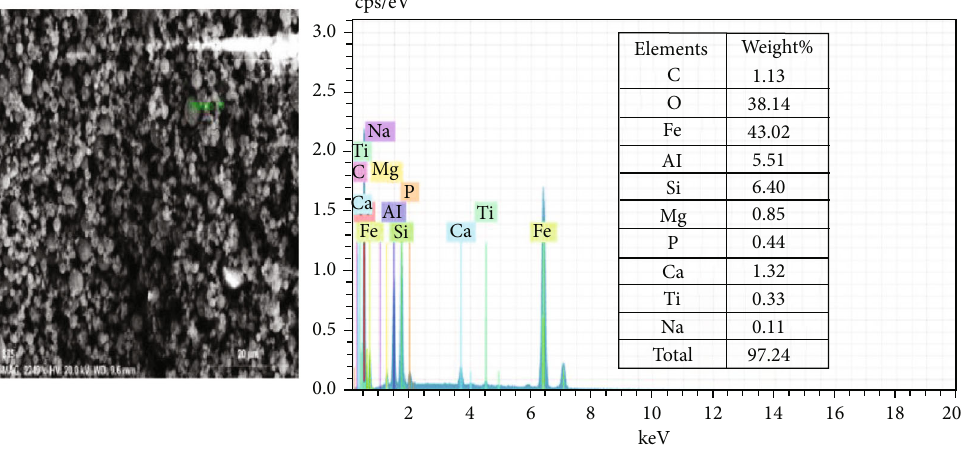
Figure 4: EDS spot, EDS spectra, and elemental composition of